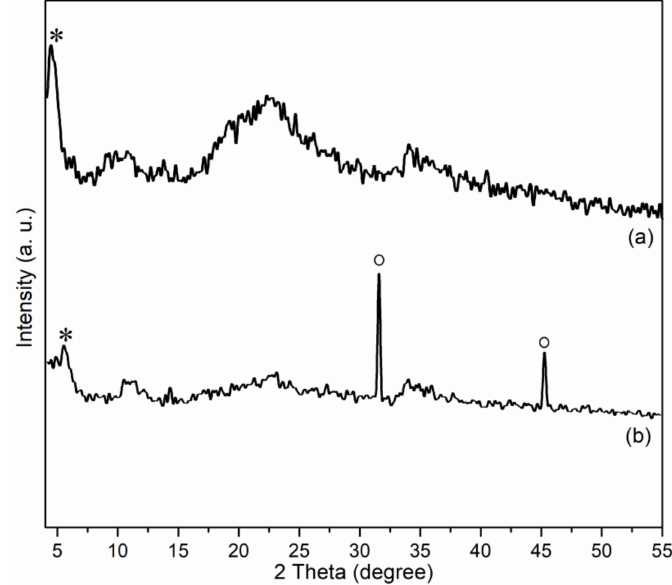
Figure 5. Powdered XRD patterns of ( a ) Zn / Al LDH and ( b )